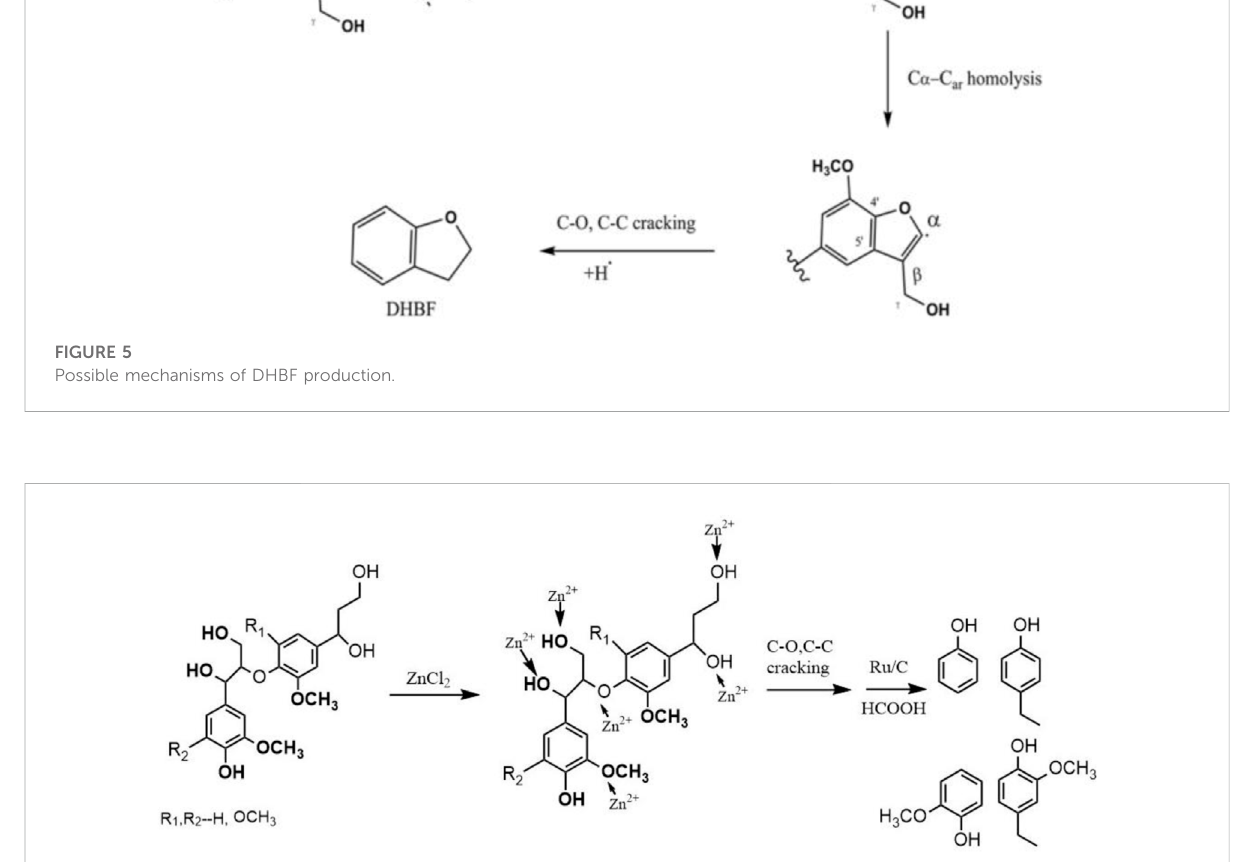
FIGURE 6 Proposed catalytic mechanism for lignin depolymerization over Ru/C and ZnCl 2